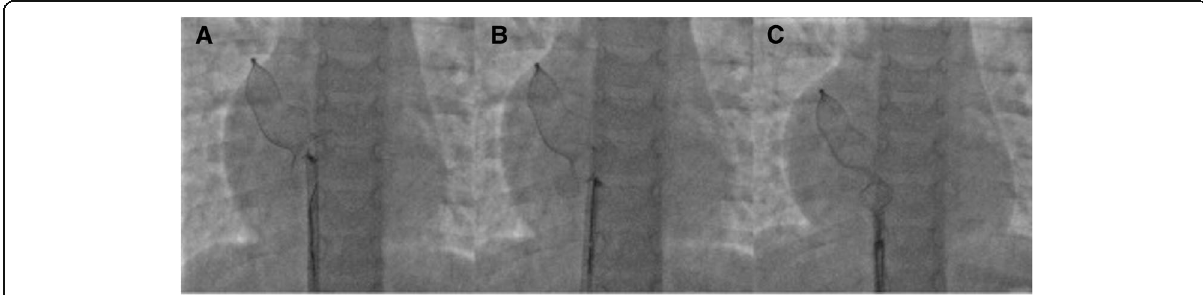
Fig. 5 Advancement of a 20-mm gooseneck snare over a larger sheath ( A ). Capture of screw on right atrial disc ( B ) and subsequent attempts to retrieve the device back into the sheath ( C ). The device however could not be retrieved into the